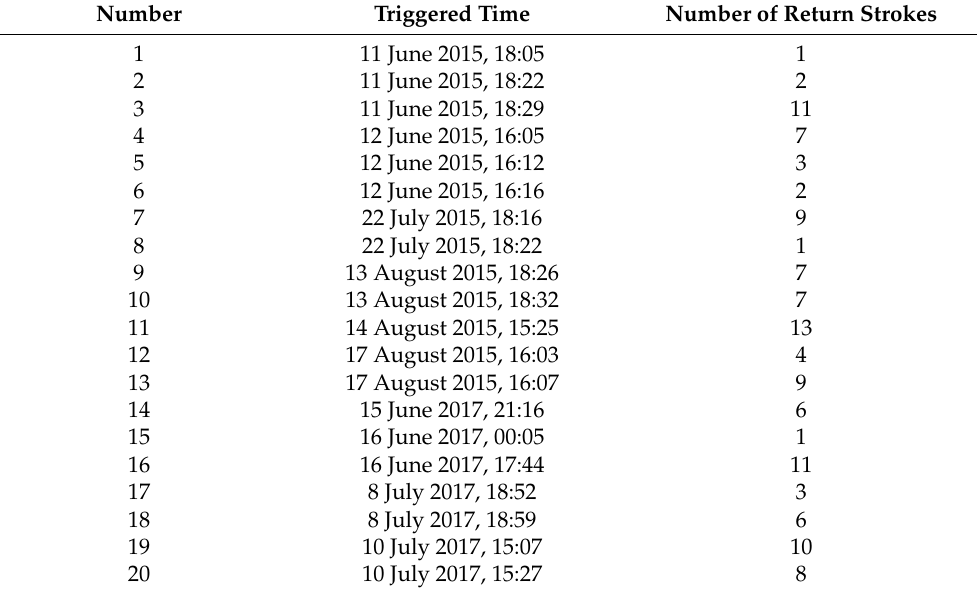
Figure 9. ( A ) Positioning results of a lightning process at 16:26 on 15 August 2015 by the EMD–TOA method and ( B ) the partial development. In each subgraph, ( a ) height–time plots; ( b ) north–south vertical projection; ( c ) height distribution of radiation events; ( d ) plan view; and ( e ) east–west vertical projection of lightning radiation sources. Refer to Figure 12 of Fan et al. [44], the graph is redrawn based on the data from https://zenodo.org/record/1133810#.YEB-6E7isdV (accessed on 4 March 2021). Table 5. Artificially triggered lightning flashes information in 2015 and